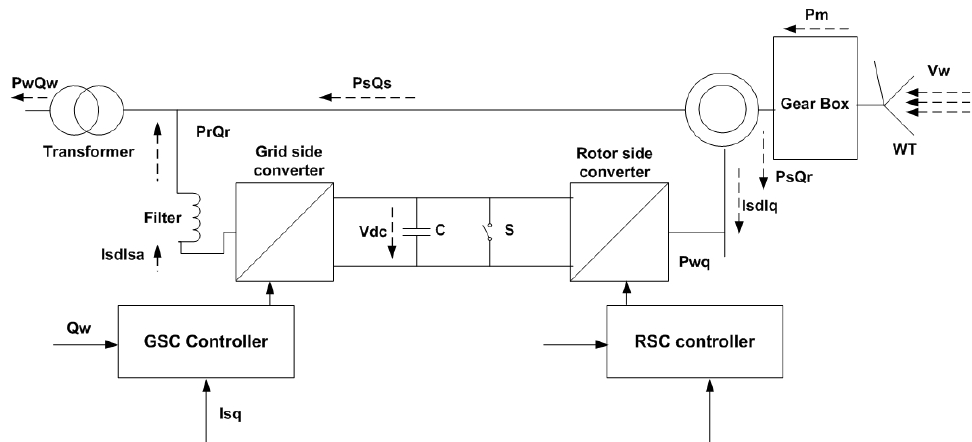
Figure 4. A typical configuration of a DFIG.